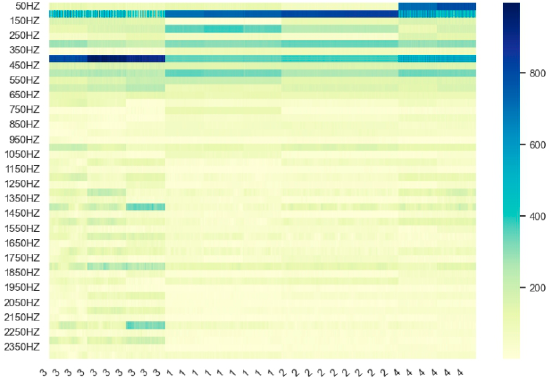
Figure 6. Clustering heat map of transformer vibration characteristics. On the basis of the vibration clusters of each transformer operating condition, the vibration spectrum amplitude is converted into discrete variables consisting of “low”, “medium”, and “high” by using the trilateration method. The information gain Gain ( D , A 400 Hz ) = 0.977 pu- rity of the vibration amplitude at 400 Hz is calculated to be the highest among the 48 vibra- tion features, so 400 Hz can be used as the root node of the transformer vibration feature decision tree model. The information gain at 50 Hz and 350 Hz in the second layer is 0.854 and 0.730, respectively, while the information gain at 50 Hz in the third layer is 0.222. The transformer vibration feature decision tree model is shown in Figure